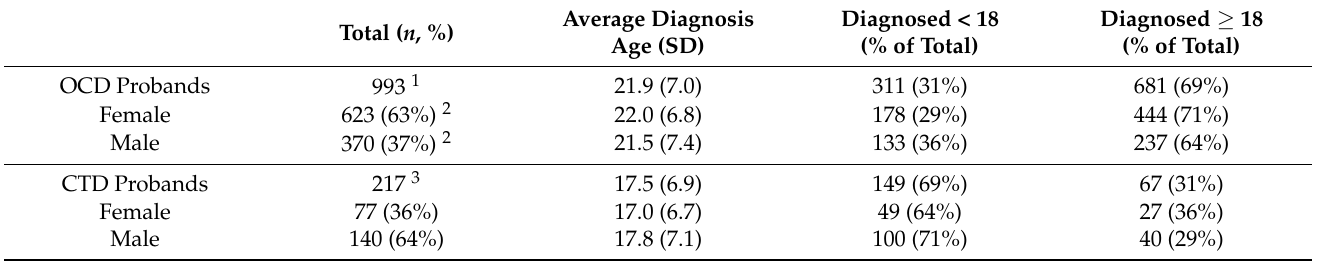
Table 1. Characterization of the OCD and CTD probands.